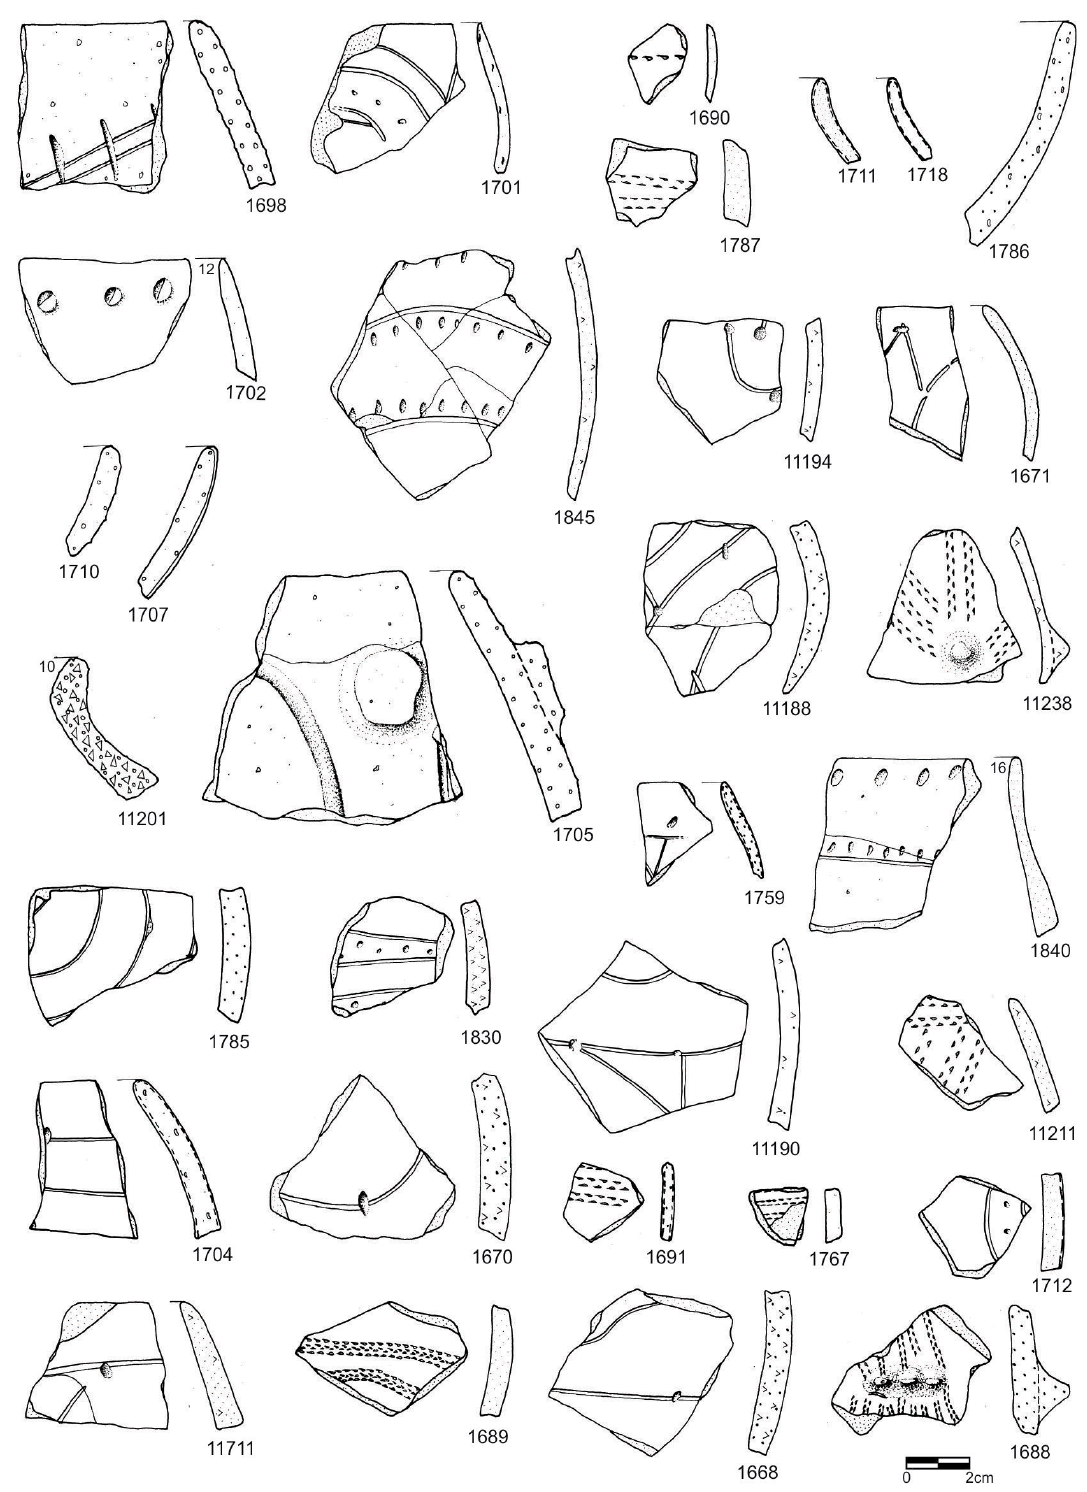
Figure 8. Selected ceramics of Hrdlovka F horizon (drawing M. Divišová, for ceramic fabric and surface treatment graphical codes see Květina & Pavlů 2007, Fig.